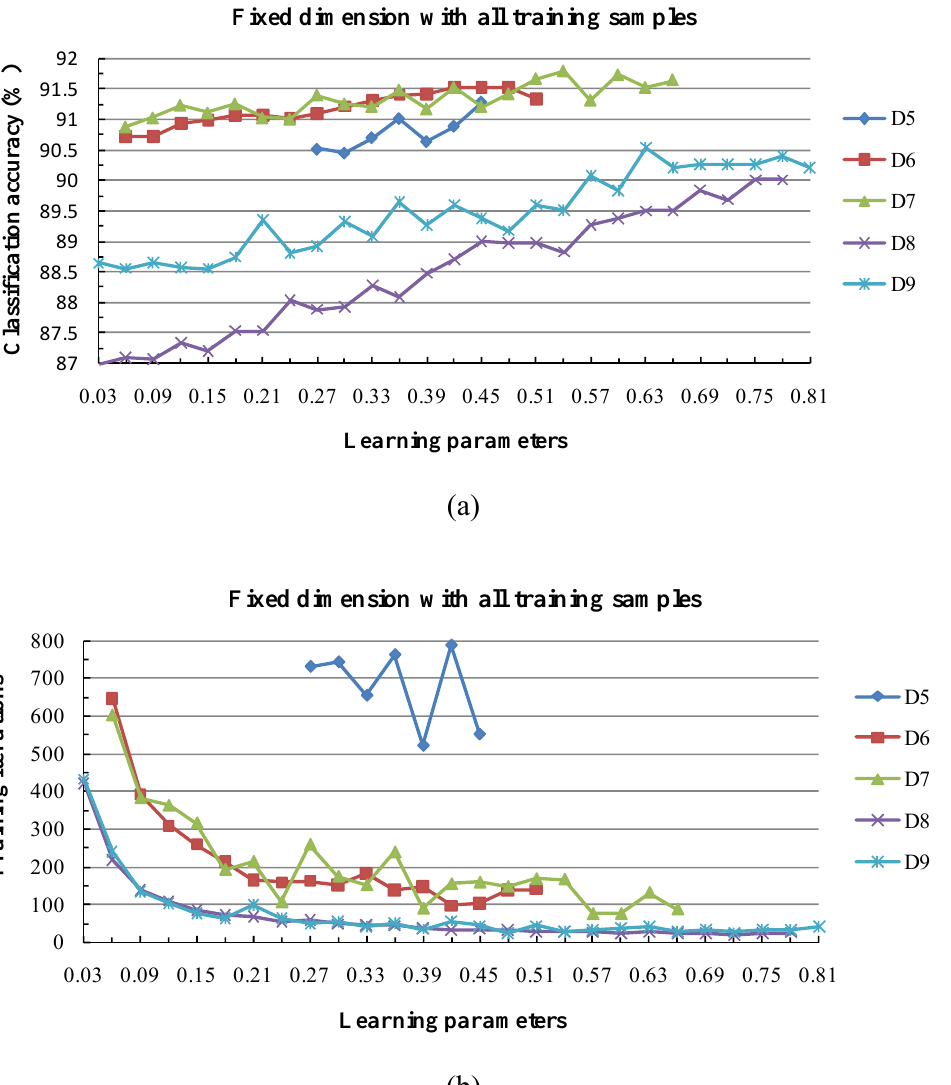
Learning parameters